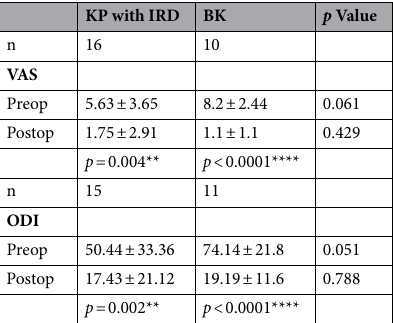
Table 2. Preoperative and postoperative clinical outcomes. ODI Oswestry disability index, Pre-op preoperative, Post-op